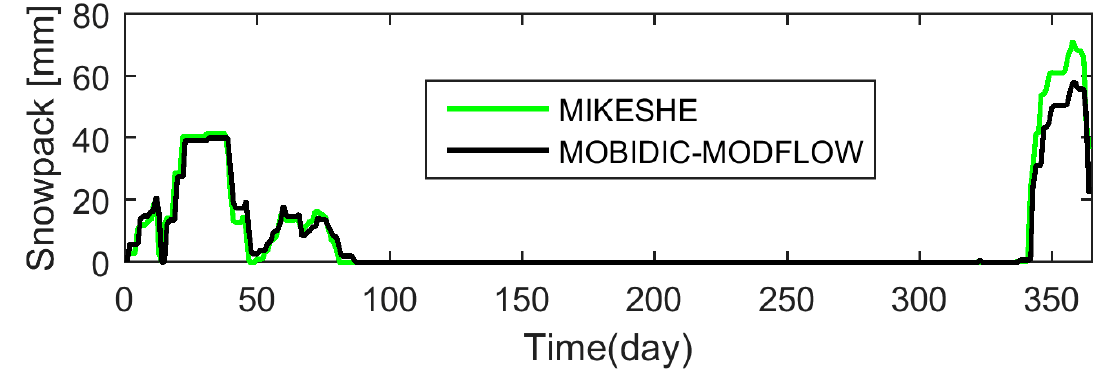
Figure 13. Simulated snowpack accumulation/depletion with MIKE SHE (green) and MOBIDIC-MODFLOW (black).